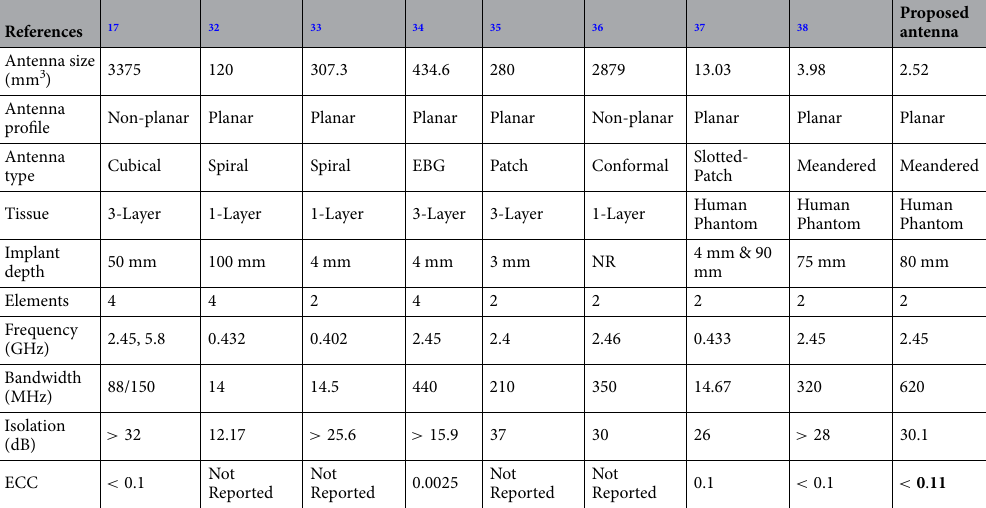
Table 1. Comparison of the proposed wideband implantable MIMO antenna with published